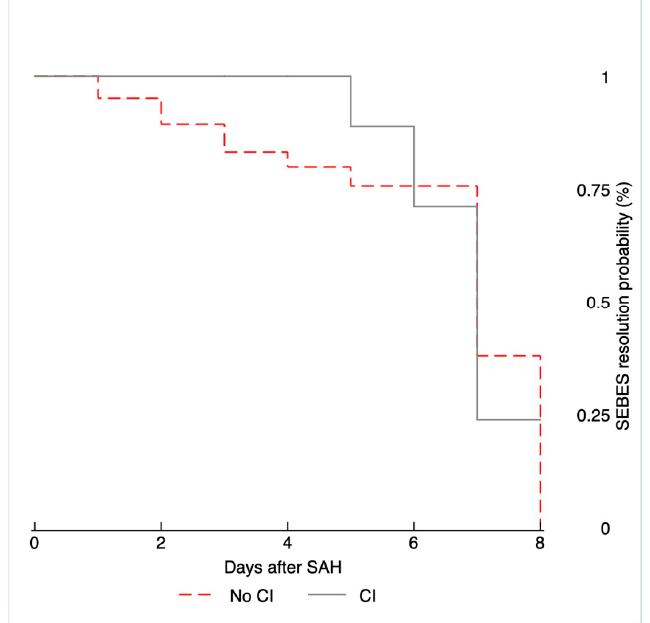
Figure 2. Kaplan–Meier curves showing cerebral edema improvement for CI and no-CI patients during the first week. Regarding the longitudinal neurological evaluations performed during the first week, there was a significant improvement in the level of consciousness measured daily through the GCS across the first week after bleeding (B = 0.36; 95% CI, 0.19–0.53); p = 0.001. The longitudinal improvement trajectories for the GCS score did not differ between the CI and no-CI groups in the linear regression model ( p = 0.536), as shown in Figure 3.